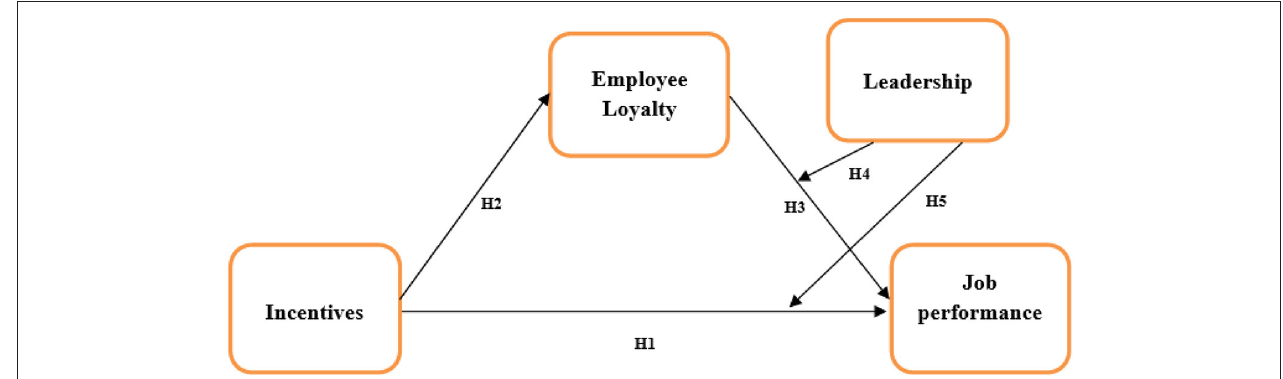
FIGURE 1 | Conceptual